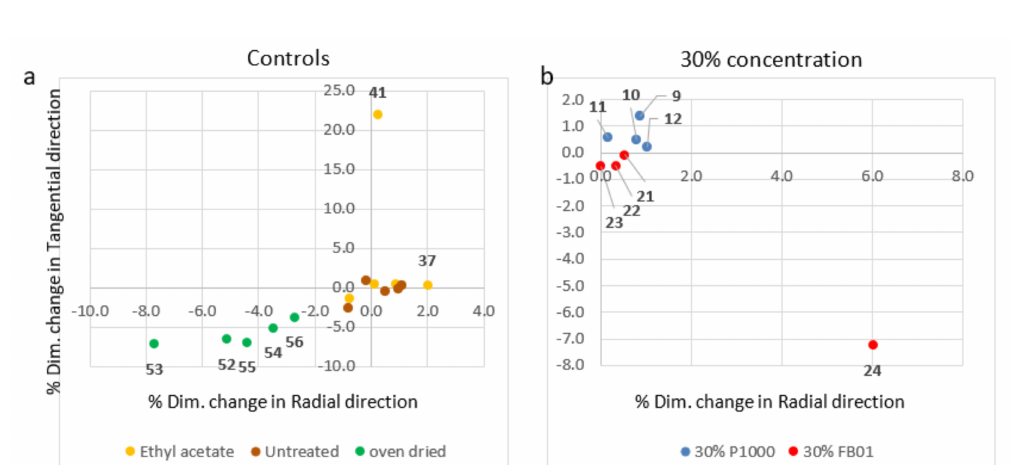
Figure 5. % Dimensional change plotted as % tangential change ( y -axis) vs. % radial change ( x -axis). ( a ) Controls, where only data points with largest changes are labelled; ( b ) 30% concentrations of P1000 and FB01 lignins. Data points are labelled with specimen